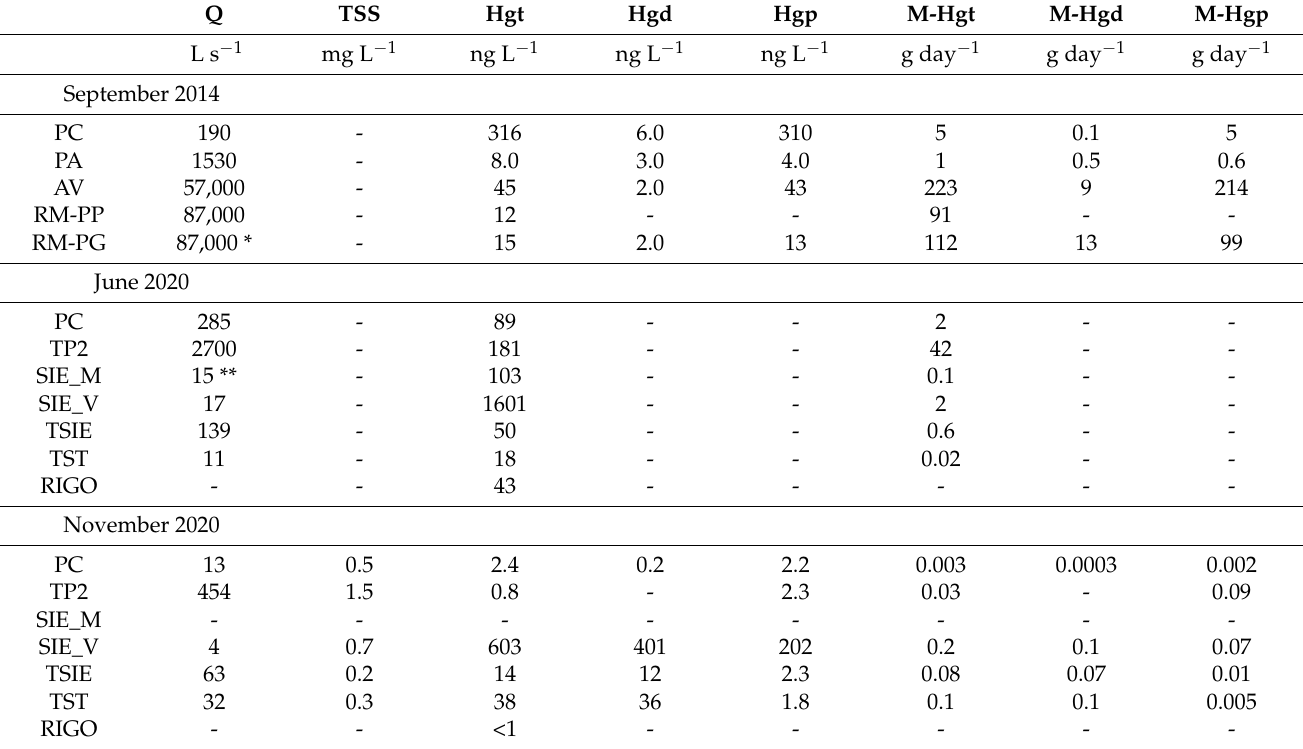
measurements were conducted with a bucket.